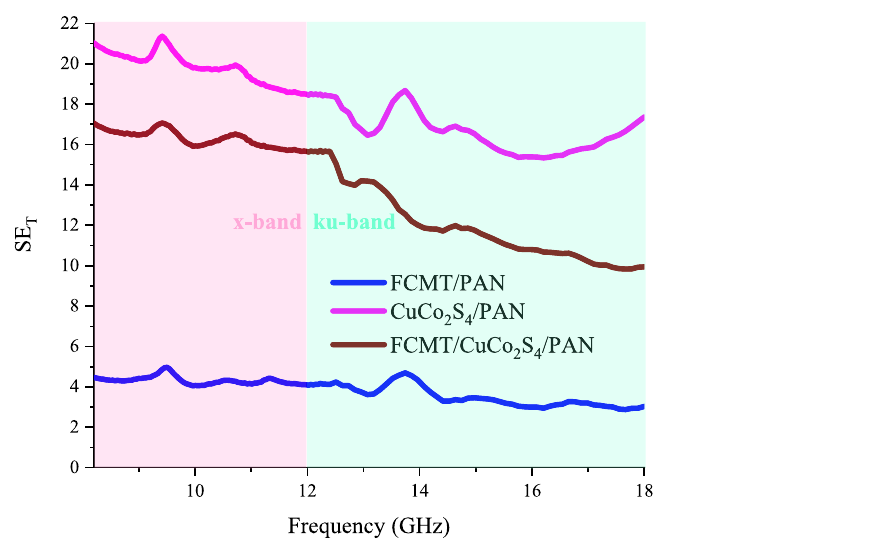
Figure 14. SE T of the absorbers at x and ku-band